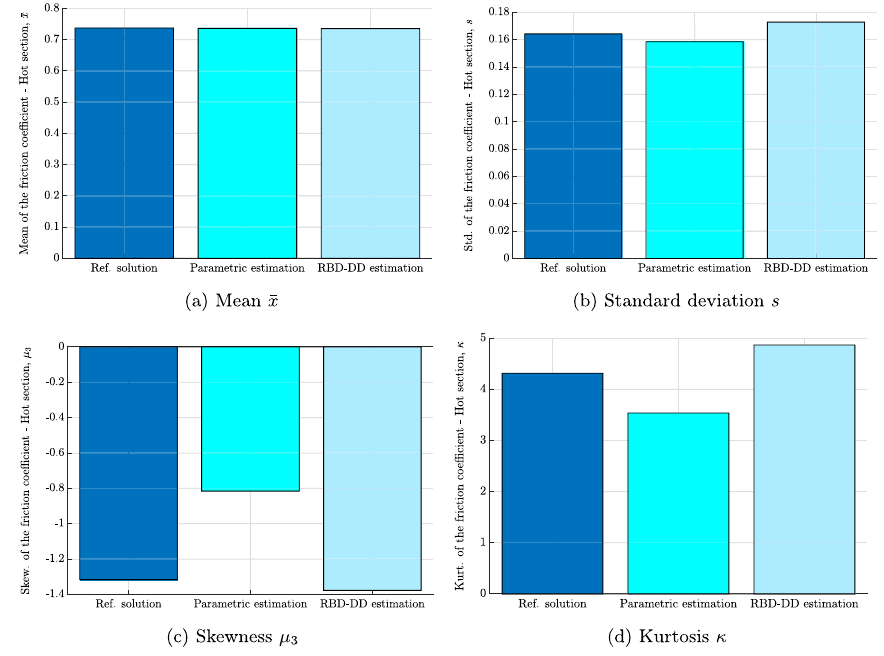
Fig. 3 The first four statistic moments for the friction coefficient of the hot section: a mean value, b standard deviation, c skewness and d kurtosis. The four statistic indicators are computed directly from (i) the measured data using Eqs. (35), (36), (37) and (38) (the reference solution), (ii) the parametric estimation using the fitted Gamma PDF and (iii) the reconstructed PDF based on the RBD-DD random generator